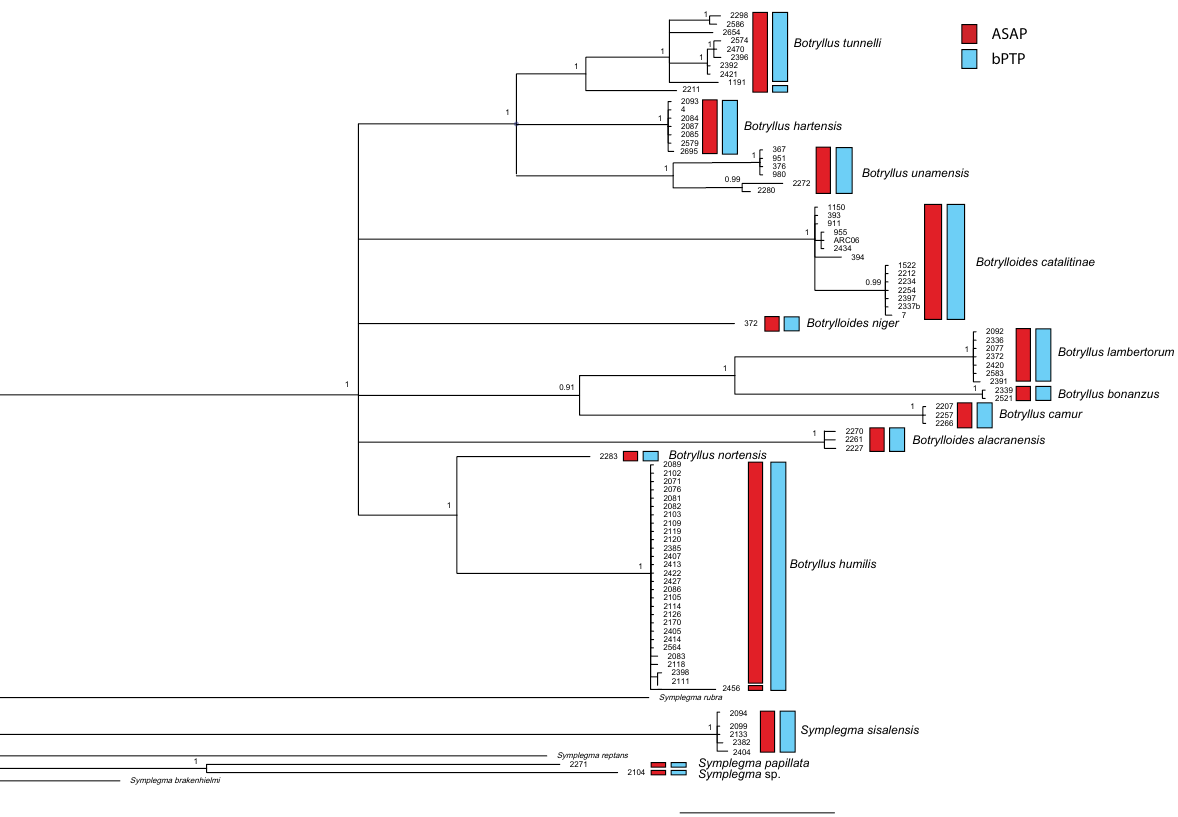
Figure 2. Species Delimitation tree constructed in a Bayesian phylogenetic framework. The numbers at the nodes are Bayesian posterior probabilities. The red bars denote species recovered by the ASAP species delimitation method. The blue bars denote species recovered by the bPTP species delimitation